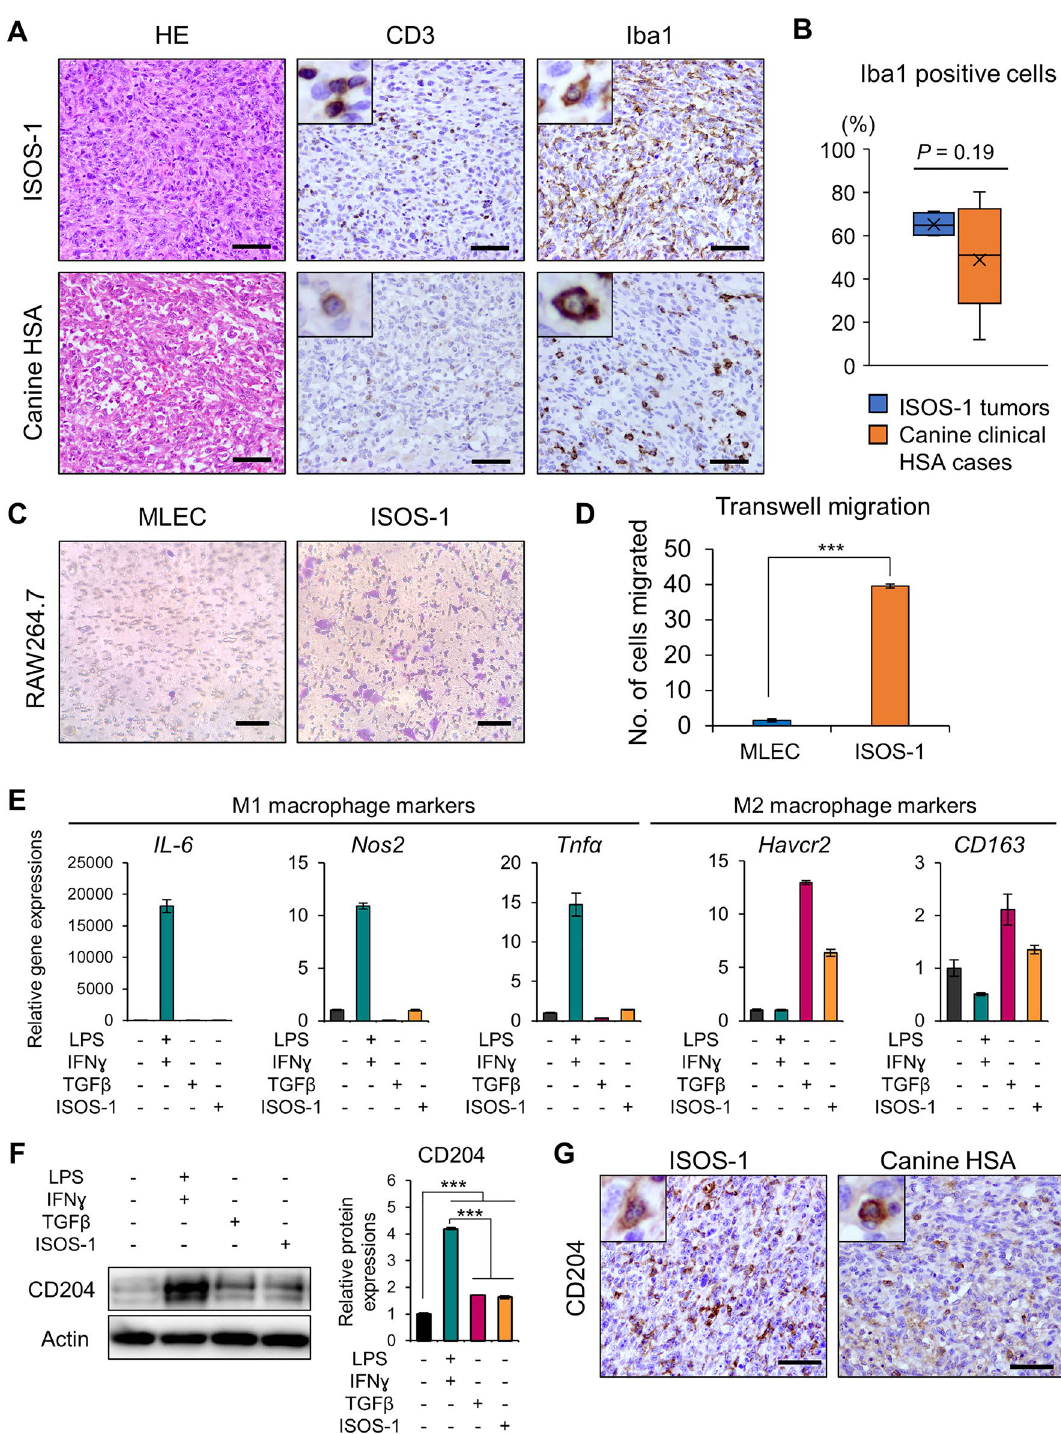
Figure 2. HSA cells attract macrophages and polarize them to M2 macrophages. ( A ) HE staining and immunohistochemistry of CD3 and Iba1 for ISOS-1 and canine HSA tumors. ( B ) Quantitative analysis of Iba1 positive cells in ISOS-1 and canine HSA tumors. Y-axis indicates the percentages of Iba1 positive cells relative to all cells comprising the tumor tissue. ( C ) Cell migration assay in RAW264.7 cells cultured over MLEC- or ISOS-1-conditioned media. ( D ) Quantitative analysis of ( C ). ( E ) Gene expressions of M1 or M2 macrophage markers in untreated, LPS and IFN-treated, TGFβ-treated, and ISOS-1 conditioned media-treated RAW264.7 cells. ( F ) (Left) Western blot analysis for CD204 in untreated, LPS and IFN-treated, TGFβ-treated, and ISOS1 conditioned media-treated RAW264.7 cells. (Right) Quantitative analysis of the western blotting data. ( G ) Immunohistochemistry of CD204 for ISOS-1 and canine HSA tumors. Scale = 125 μm. Data are presented as mean values ±